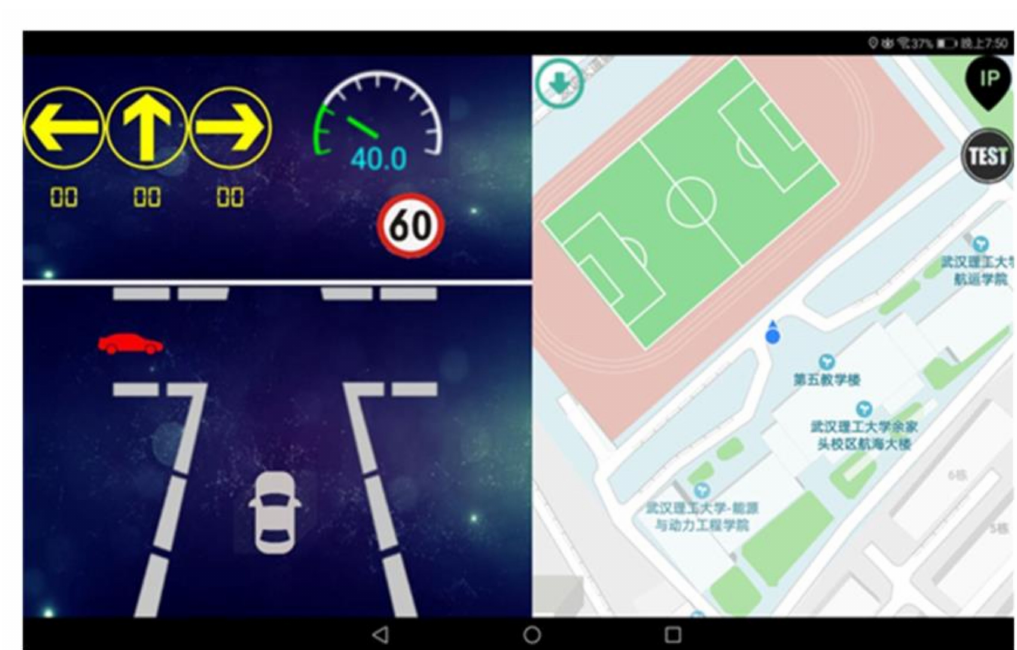
Figure 6. Demonstration of collision warning effect at non-signalized intersections.